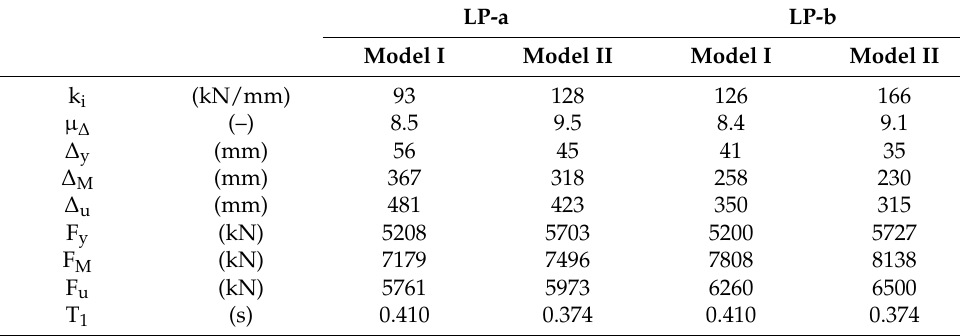
Figure 7. Building capacity curves for LP-a and LP-b. Table 4. Structural performance parameters of the